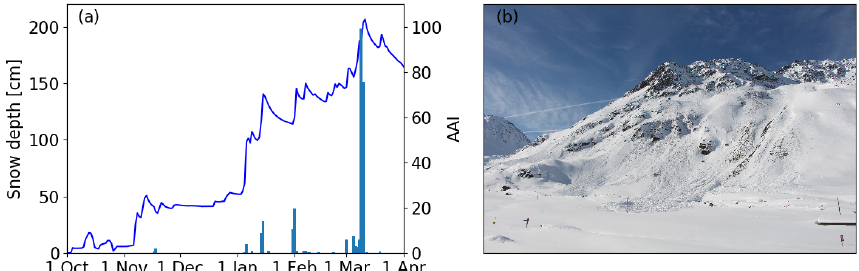
Figure 2. (a) Evolution of modeled snow depth (full line) for the winter season 2016–2017 at the WFJ field site above Davos, Switzerland, and avalanche activity index (AAI) observed in the region of Davos (blue bars). (b) Avalanches that occurred during the cycle of 9–10 March 2017, in the valley of Dischma, Davos (picture taken on 15 March 2017). Often the ground or rocks are visible on the bed surface. This was a typical phenomenon for the winter season 2016–2017 due to the old snow problem.